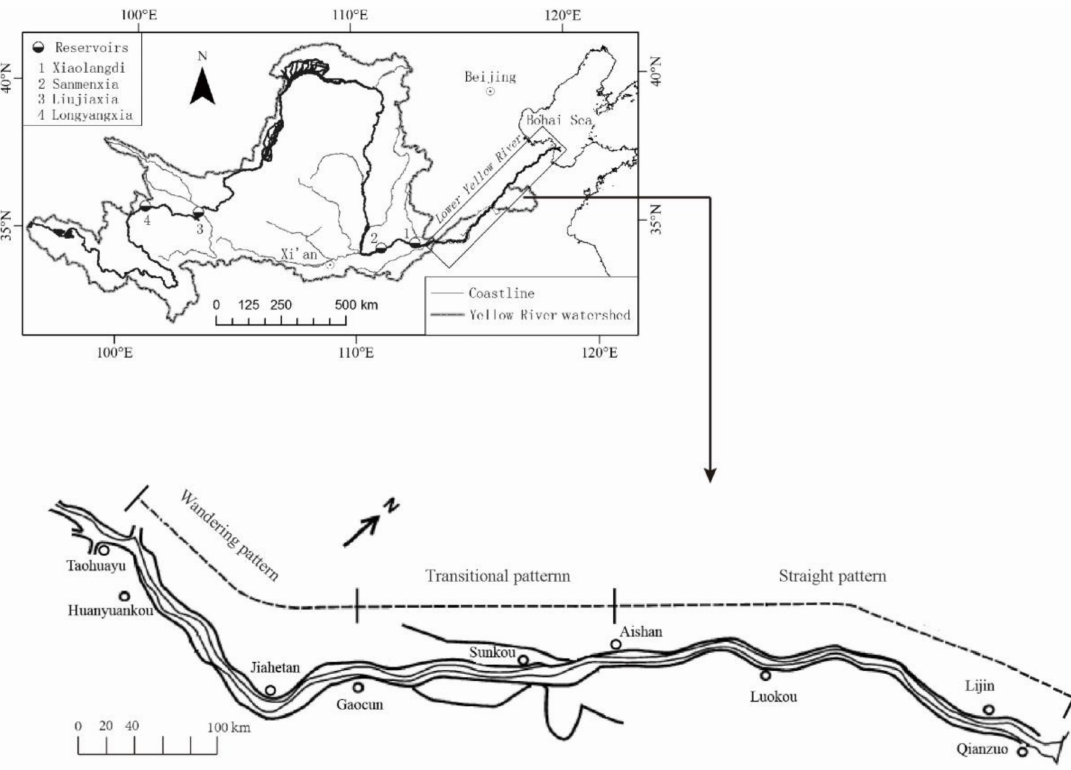
Figure 1. The lower Yellow